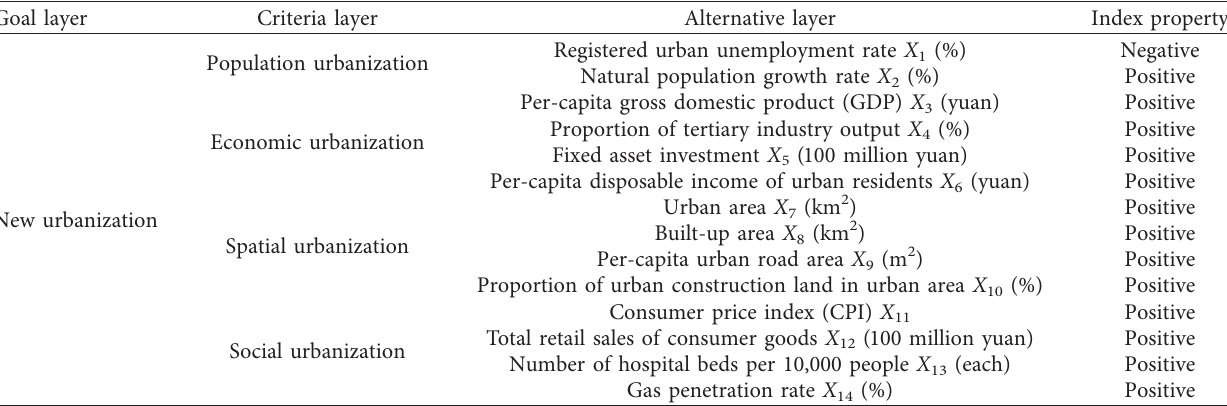
Table 3: CES of new urbanization.